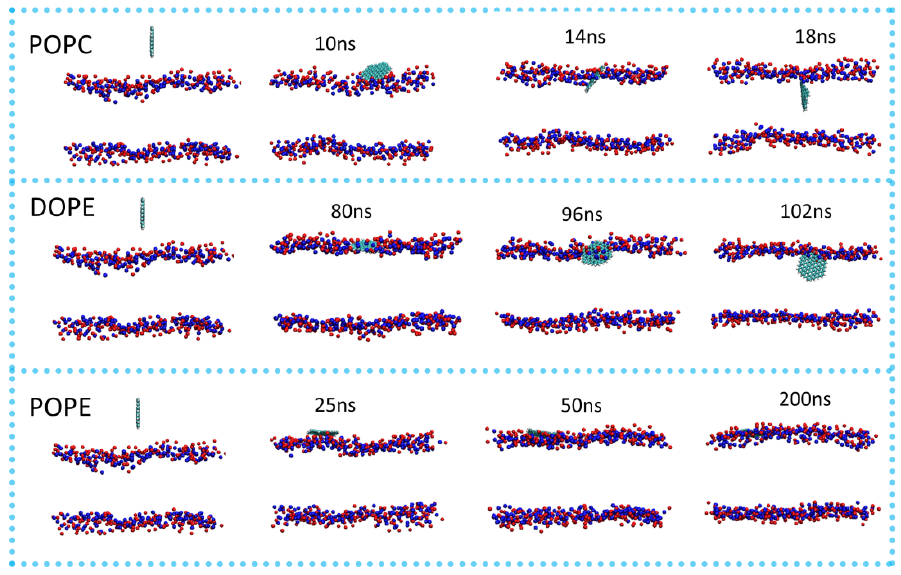
Figure 3. Permeation of GQDs through different cell membranes. P atoms in the cell membrane are shown as blue spheres, and N atoms are shown as red spheres. All instantaneous screenshots were produced using VMD software.